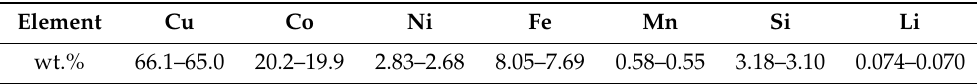
Table 5. Composition of quenched metal in wt.%.